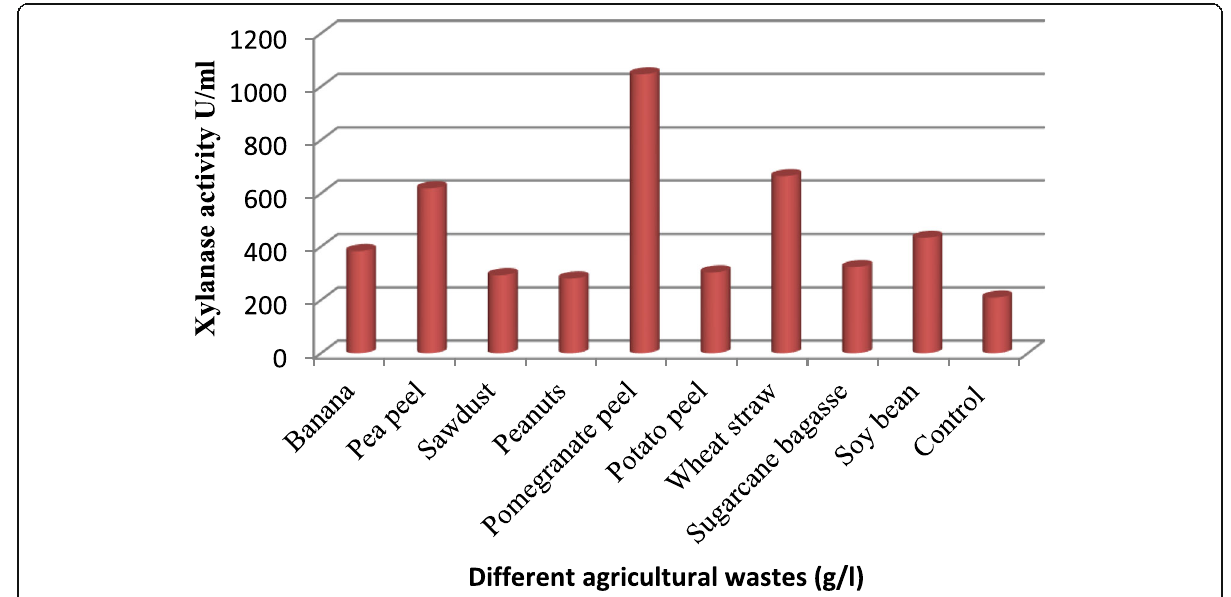
Fig. 1 Effect of different agricultural wastes on xylanase production by C. globosum